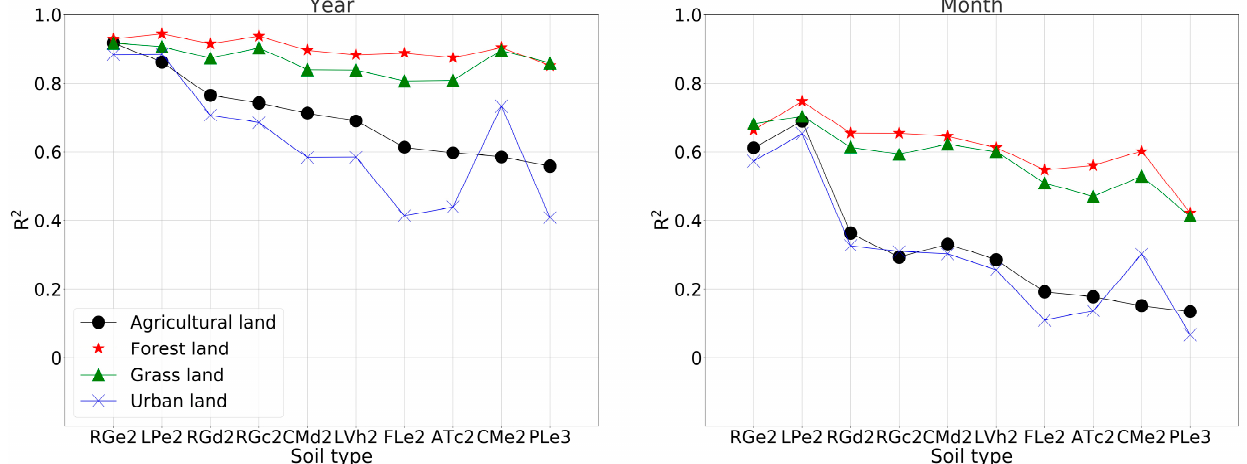
Figure 8. The R 2 of each MLR formulation for different combinations of land use and soil type. The form of the formulation is shown in Table 1. The soil type name of each soil type code refers to Figure